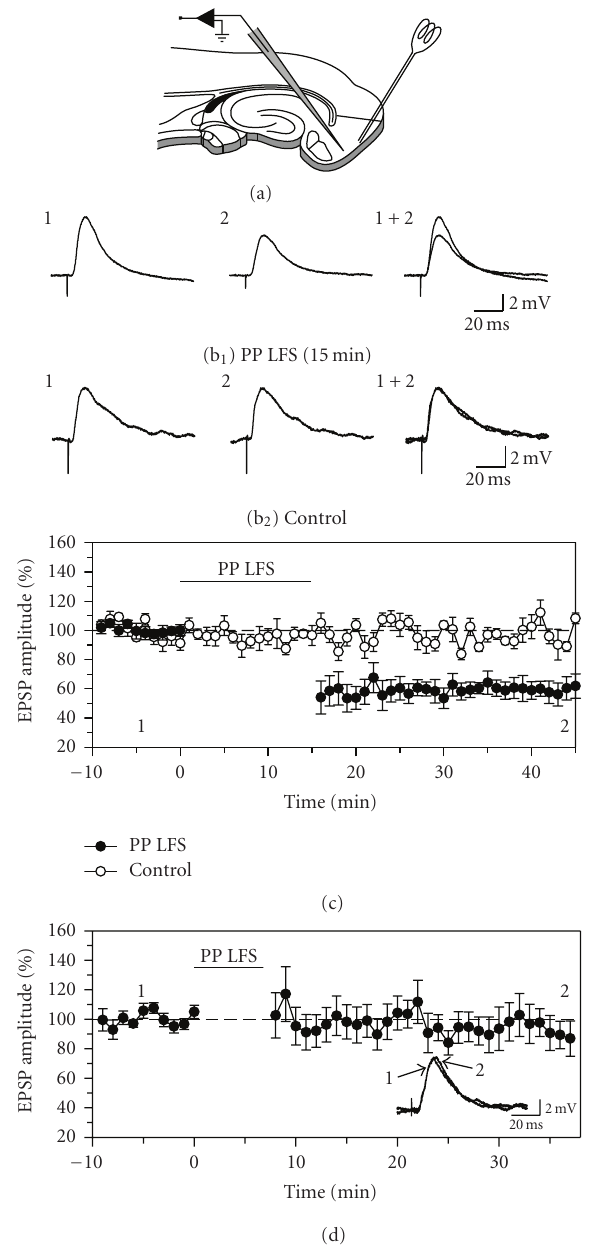
Figure 1: Prolonged, low-frequency stimulation induces long-term depression of EPSPs in neurons in layer II of the entorhinal cortex. (a) The location of stimulating and recording electrodes in acute slices containing the entorhinal cortex. (b) and (c) Long-term depression was induced by repetitive delivery of pairs of stimulation pulses at a rate of 1 Hz for 15 minutes (PP-LFS). The amplitude of synaptic responses remained stable in control cells that did not receive conditioning stimulation. Traces in (b) compare responses recorded during the baseline period (1) and during the follow-up period (2) in a neuron that received low-frequency stimulation (b 1 ) and in a control cell (b 2 ). Responses were obtained at the times indicated in (c). Averaged points in (b) indicate the mean ± 1 SEM in this and subsequent figures. (d) Long-term depression was not reliably induced when low-frequency stimulation was delivered for only 7.5 minutes rather than 15 minutes, indicating that induction of LTD requires prolonged stimulation.